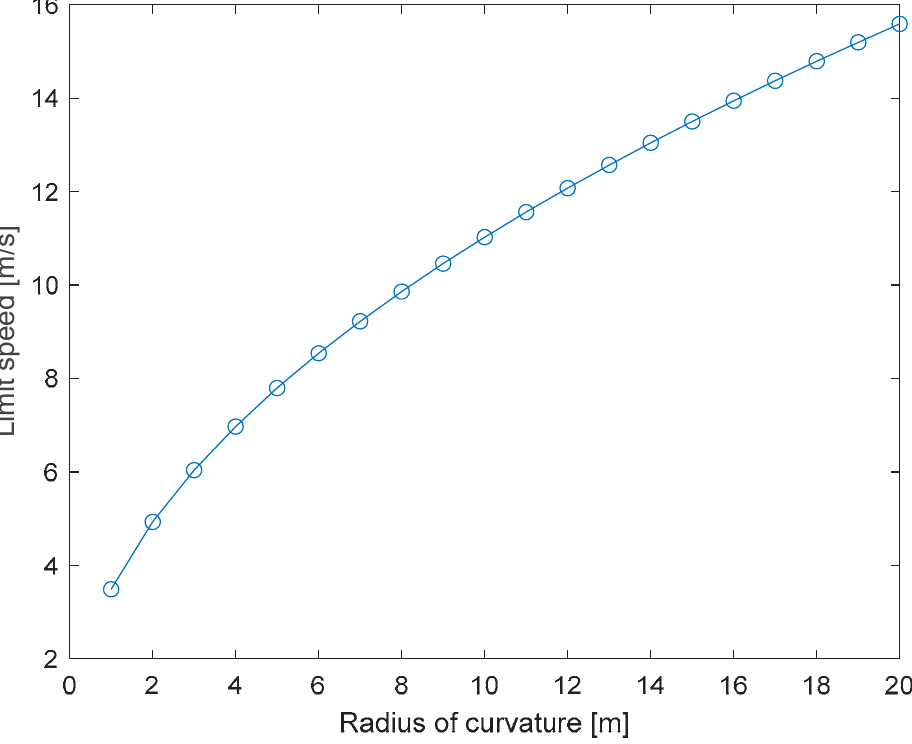
Figure 30. Capsizing speed limit for h = 50 cm and 𝑏